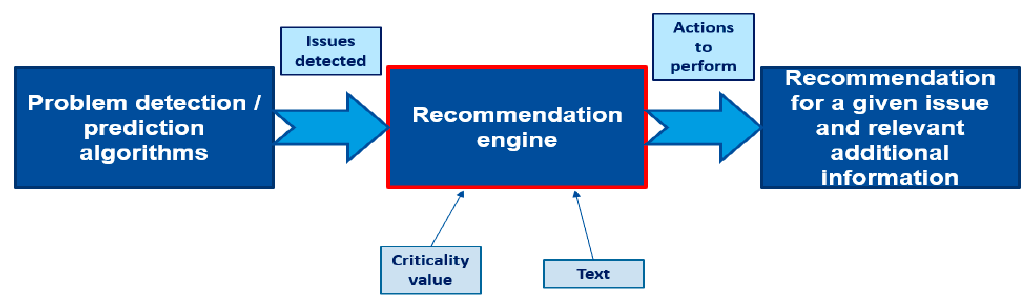
Figure 5. Process from problem detection to generation of recommendations.